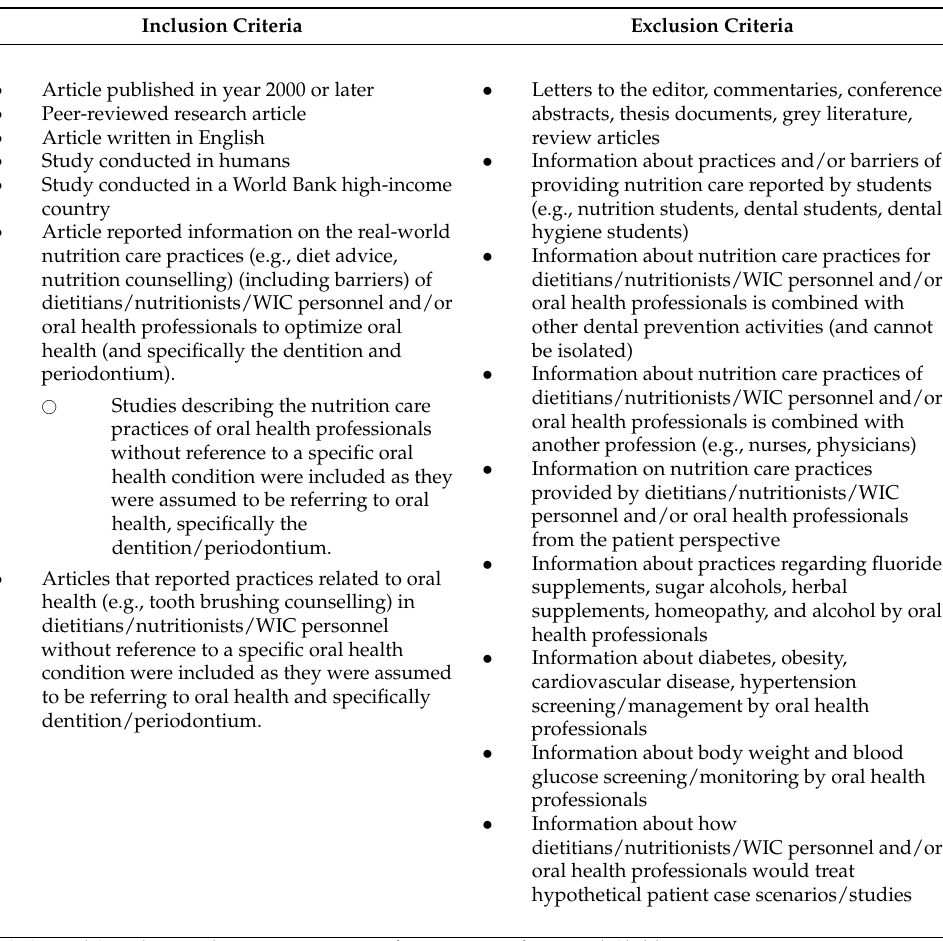
Table 2. Inclusion and exclusion